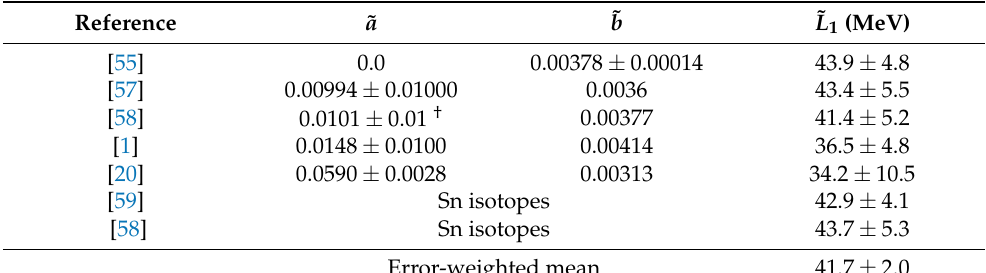
Table 2. Coefficients for the relation r 208 np = ˜ a /fm + ˜ b ˜ L 1 /MeV and inferred values of ˜ L 1 from the error-weighted mean experimental value r 208 np = 0.166 ± 0.017 fm. Also given are two estimated values of ˜ L 1 from neutron skin measurements of Sn isotopes. † 0.01 fm uncertainty introduced for consistency.